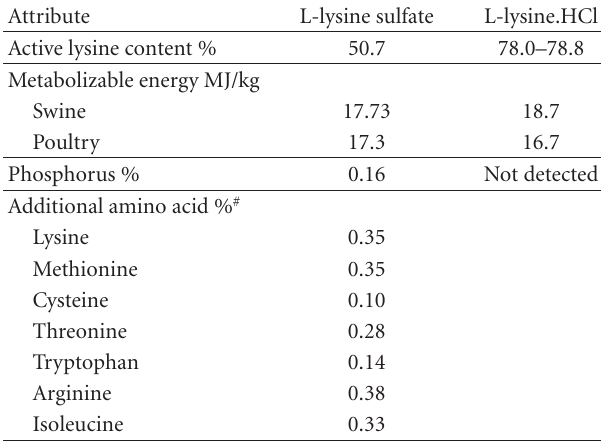
Table 2: Chemical composition of L-lysine sulfate and L- lysine.HCl †